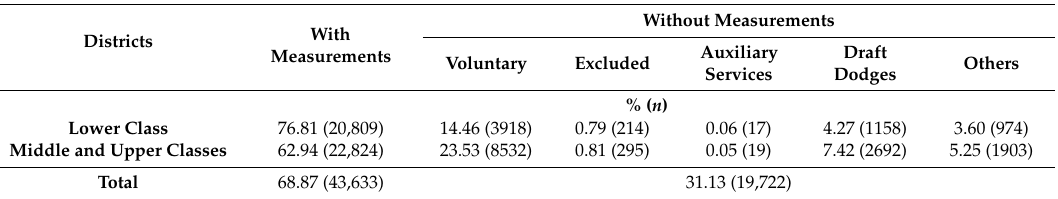
Table 1. Distribution of data of conscripts by district and availability of anthropometric measurements (Source: